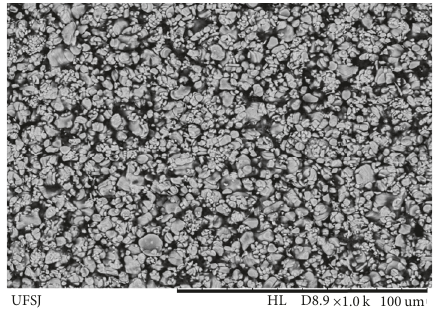
Figure 4: Scanning Electron Microscopy (SEM) of LIB spent cathode tape.